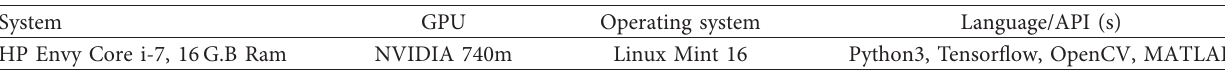
Table 2: Computational resources.